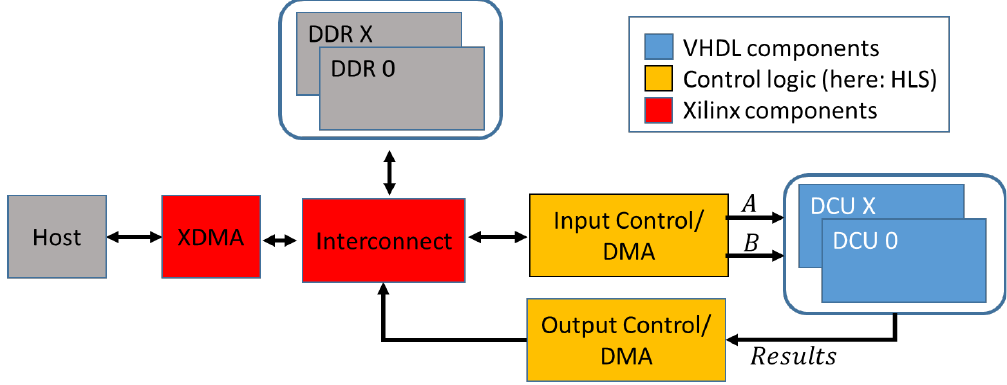
Figure 1. Overview of the system